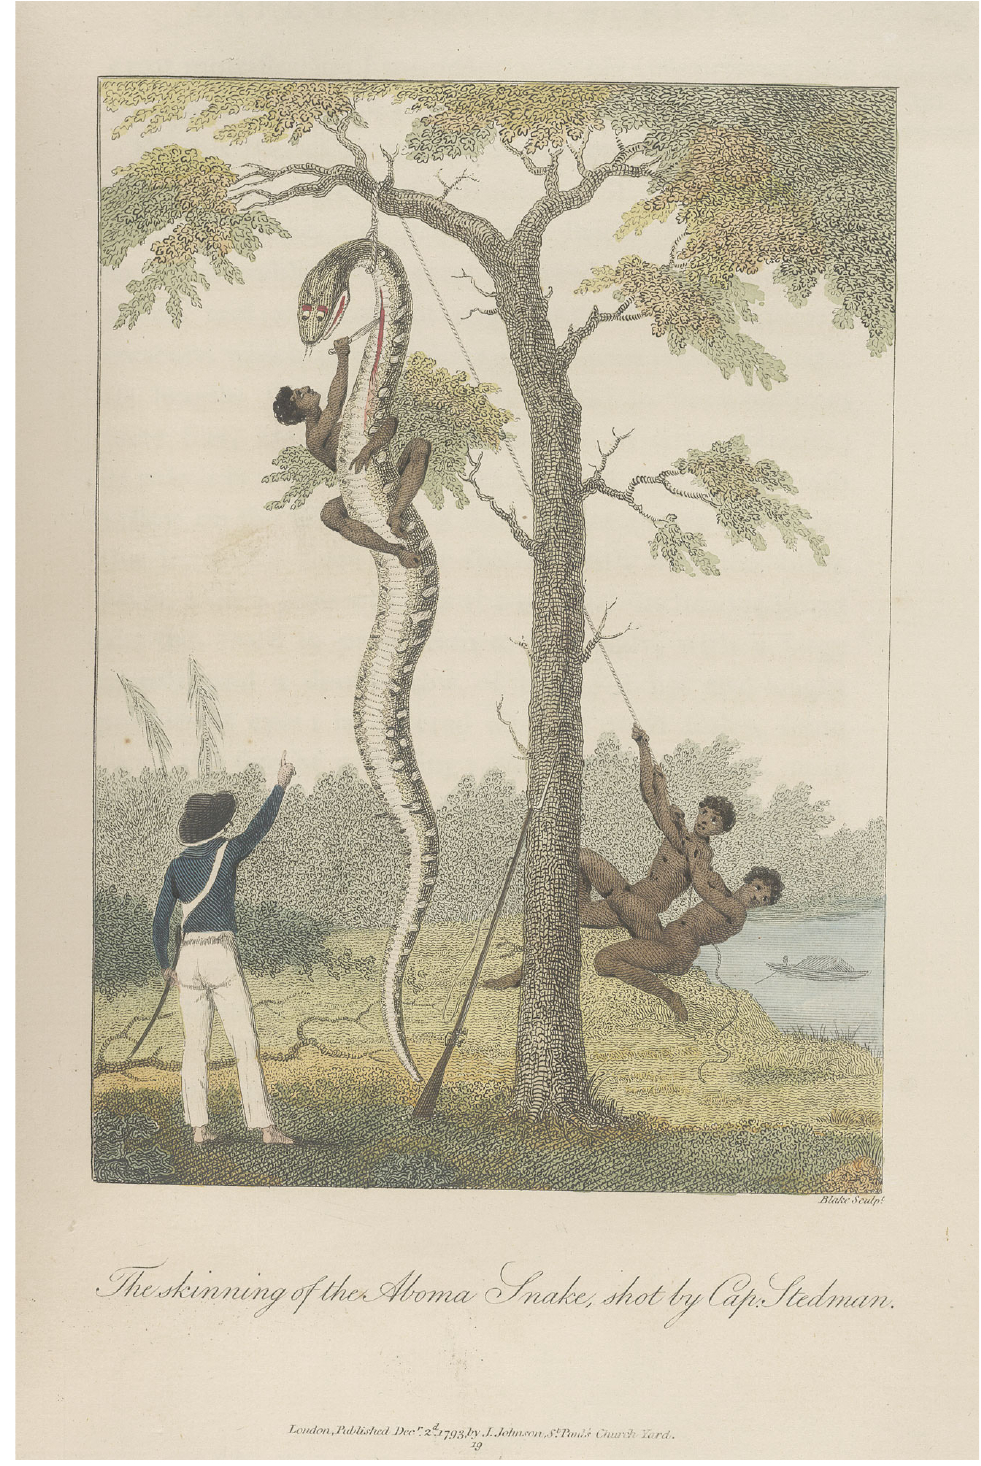
Figure 1. “The Skinning of the Aboma Snake, shot by Cap. Stedman” engraved by William Blake (1796). Public Domain.